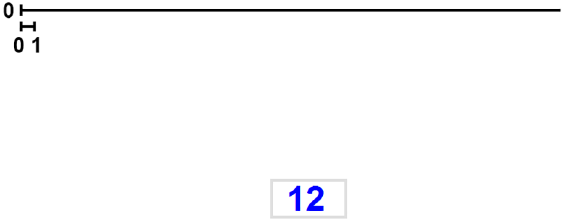
Figure 2. Illustration of the unbounded number line estimation